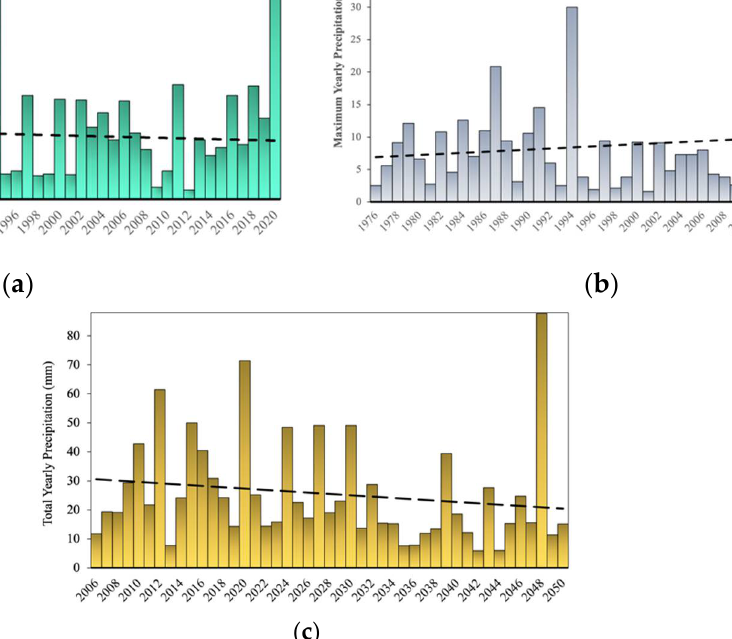
Figure 9. ( a ) Total rainfall every year (mm/year) for the period of 1976 to 2020; ( b ) maximum rainfall event in each year (mm/day) for the period of 1976 to 2020; ( c ) total annual projected precipitation during the period 2006 to 2050 from the CNRM model for RCP4.5; the dashed inclined lines show the trend of the rainfall (whether increasing or decreasing).